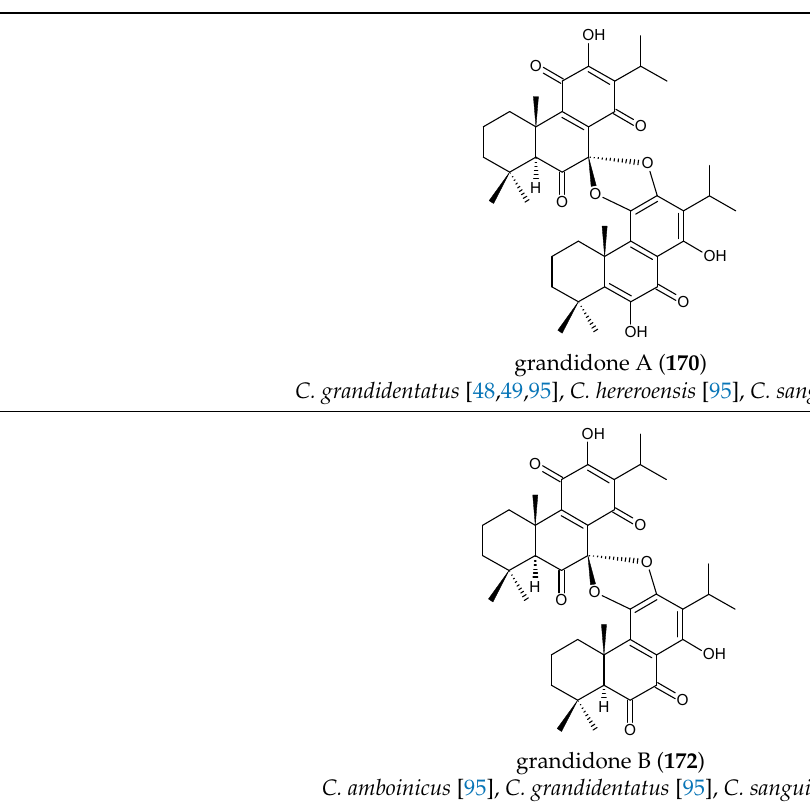
Table 6. Dimeric diterpenes of the genus Plectranthus s.l.